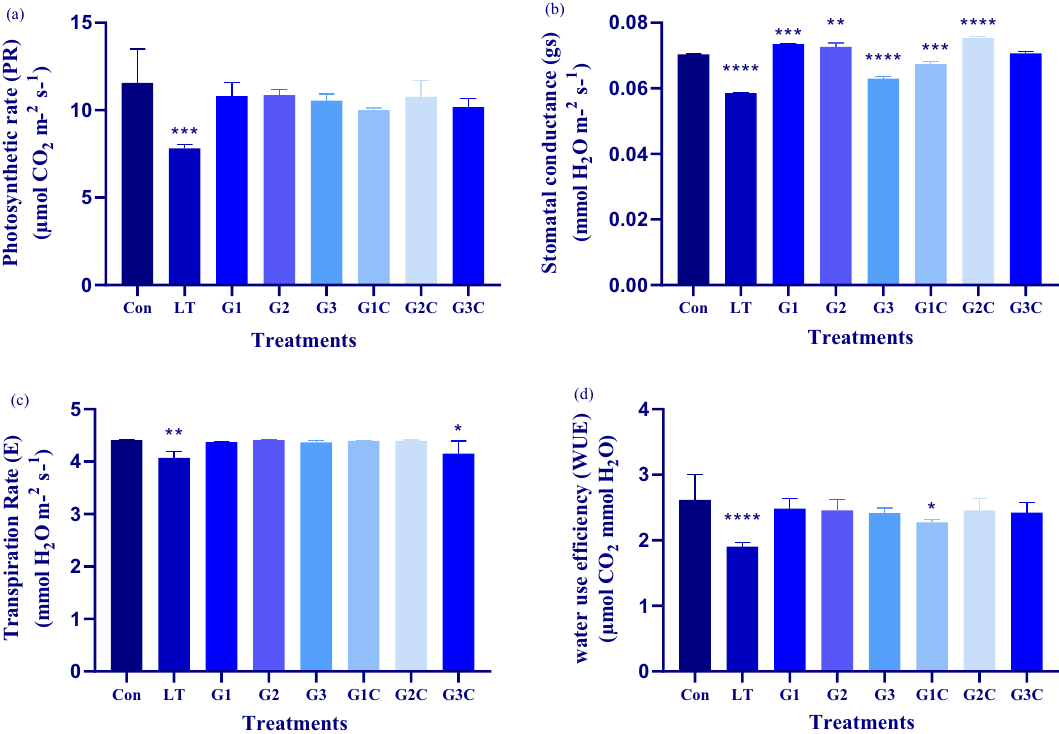
Figure 4. Effect of cold stress and different GSH concentrations on leaf gas exchange parameters: Forty days after sowing seedlings were used for experimentation pertaining to LT stress and exogenously applied GSH. Post 3 days recovery determination of ( a ) photosynthetic rate, ( b ) stomatal conductance, ( c ) Transpiration rate and ( d ) water use efficiency was done. The data depicts the mean and standard deviation of three replicates. Data followed by (*) determines level of significance ( p < 0.05) as predicted by Dunnet’s multiple comparison test. Control (Con): 25/18 °C + 0 mM GSH , Low temperature stress (LT): 10/3 °C + 0 mM GSH,